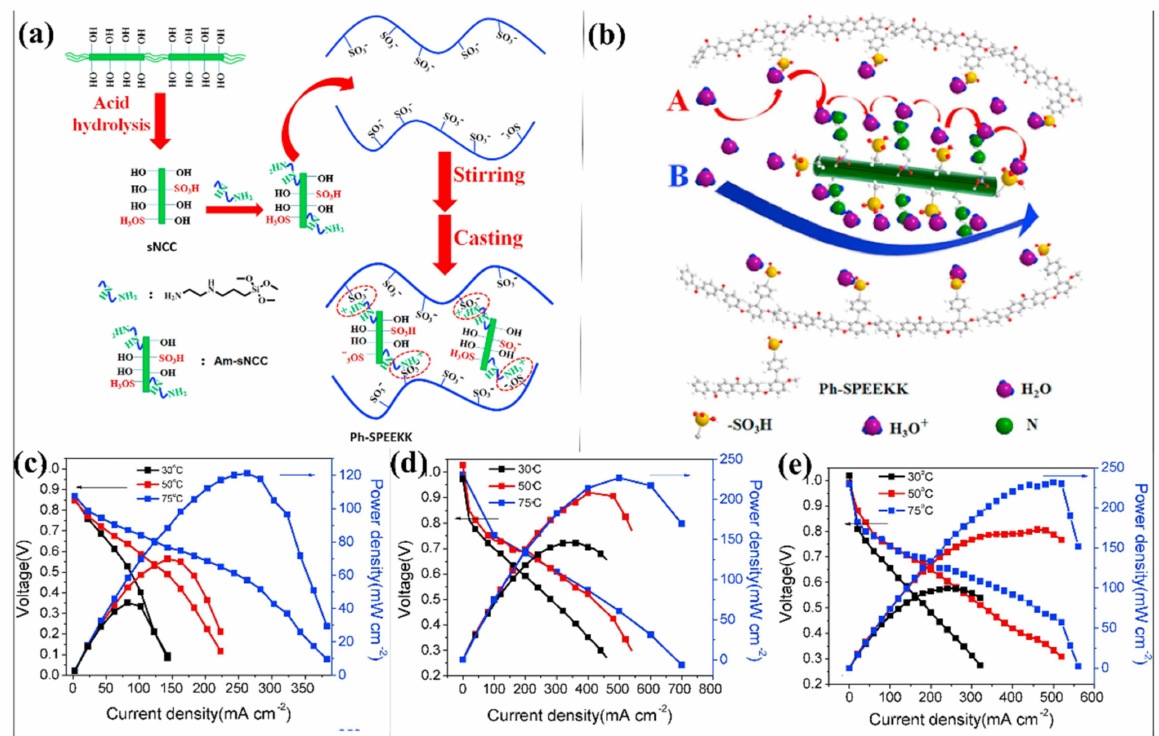
Figure 7. Schematic representation of Ph − SPEEKK and Am − sCNC cross-linked membranes ( a ) preparation process and ( b ) proton transport pathways. ( c ) PEMFC performances at differ- ent temperatures (30 ◦ C, 50 ◦ C, and 75 ◦ C): ( c ) Ph − SPEEKK, ( d ) Ph − SPEEKK − Am3 − sCNC − 5, and ( e ) Ph − SPEEKK − Am3 − sCNC-8 membranes. Reprinted with permission from Ref. [121]. Copyright © 2018 Elsevier B.V. (License Number: